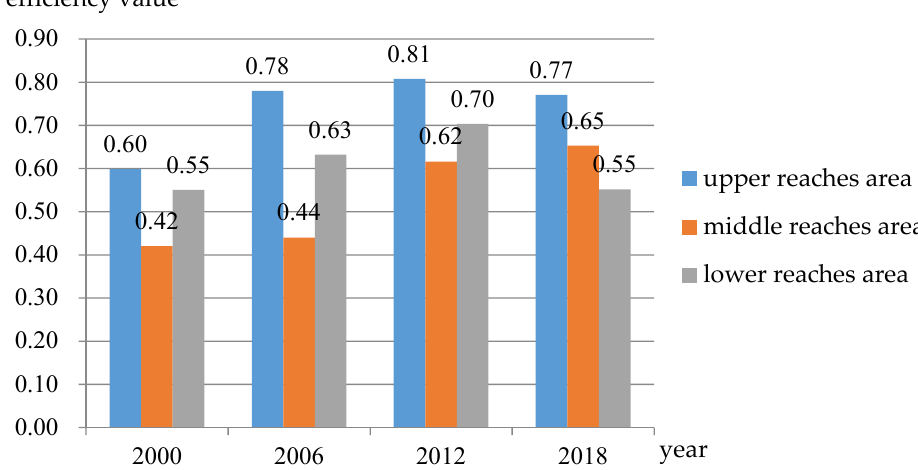
Figure 4. Changes of GUECL in the upper, middle and lower reaches of the Yellow River Basin.